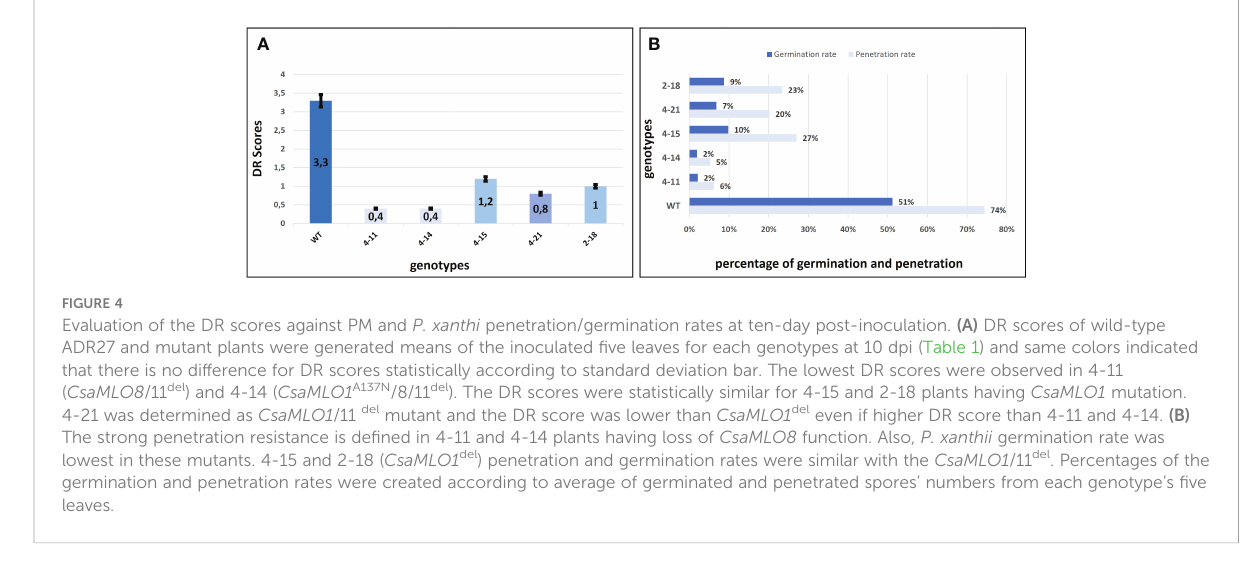
(Figure 4). Low spore germination and limited mycelial growth was observed on the 4-11 and 4-14 plants.